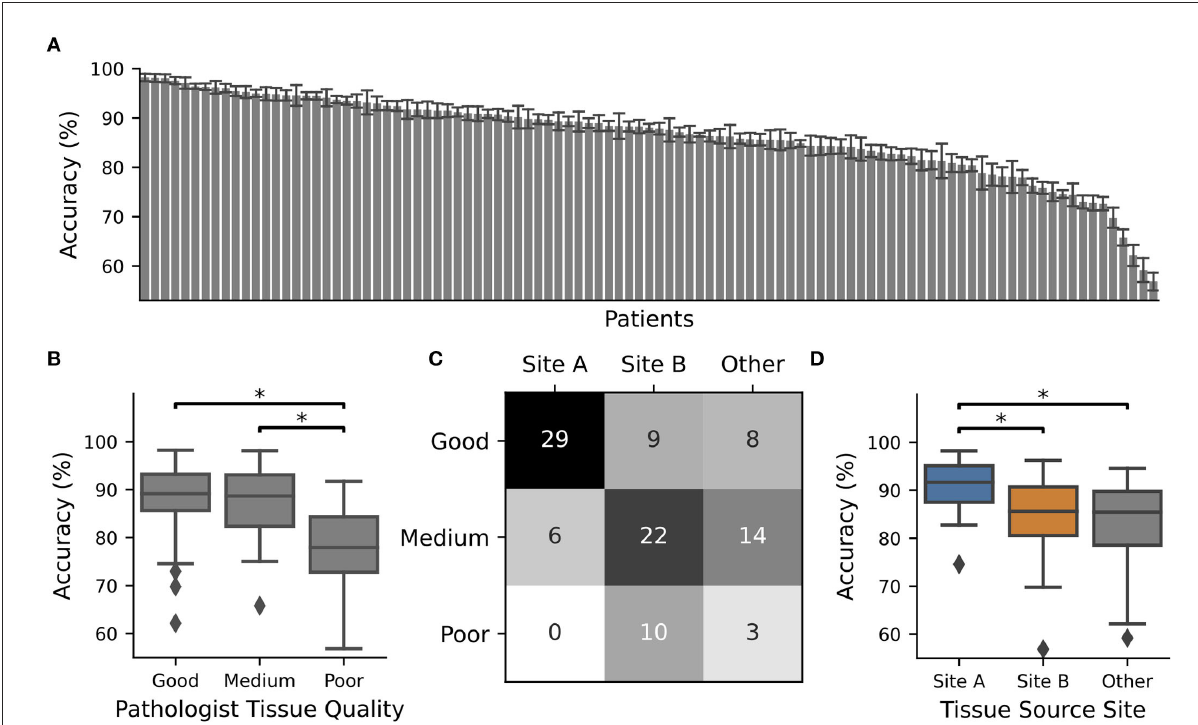
FIGURE1 CNN performance depended on tissue quality and tissue source site. The TCGA-OV dataset was split into four subsets and 4 x 15 individual CNNs were trained with different train-validation splits using one subset as a test. The whole procedure was repeated 10 times. CNN performance was only recorded for WSIs in the test set. (A) Average accuracy for each WSI. The identifier with their accuracy is given in Supplementary Table S1. Error bars depict standard deviation. (B) Boxplot over the accuracy values of all slides with pathologist P1 assigned tissue quality. At least one category is significantly different according to an ANOVA ( p = 0.00011), and significant differences between groups ( post-hoc t -test with Bonferroni Holm p -value adjustments, p < 0.05) are marked with *. (C) Contingency table for tissue source site vs. tissue quality. (D) Boxplot over the accuracy values of all slides from different tissue source sides. At least one category is significantly different according to an ANOVA ( p = 0.00005) and significant differences between groups ( post-hoc t -test with Bonferroni Holm p -value adjustments, p < 0.05) are marked with *.